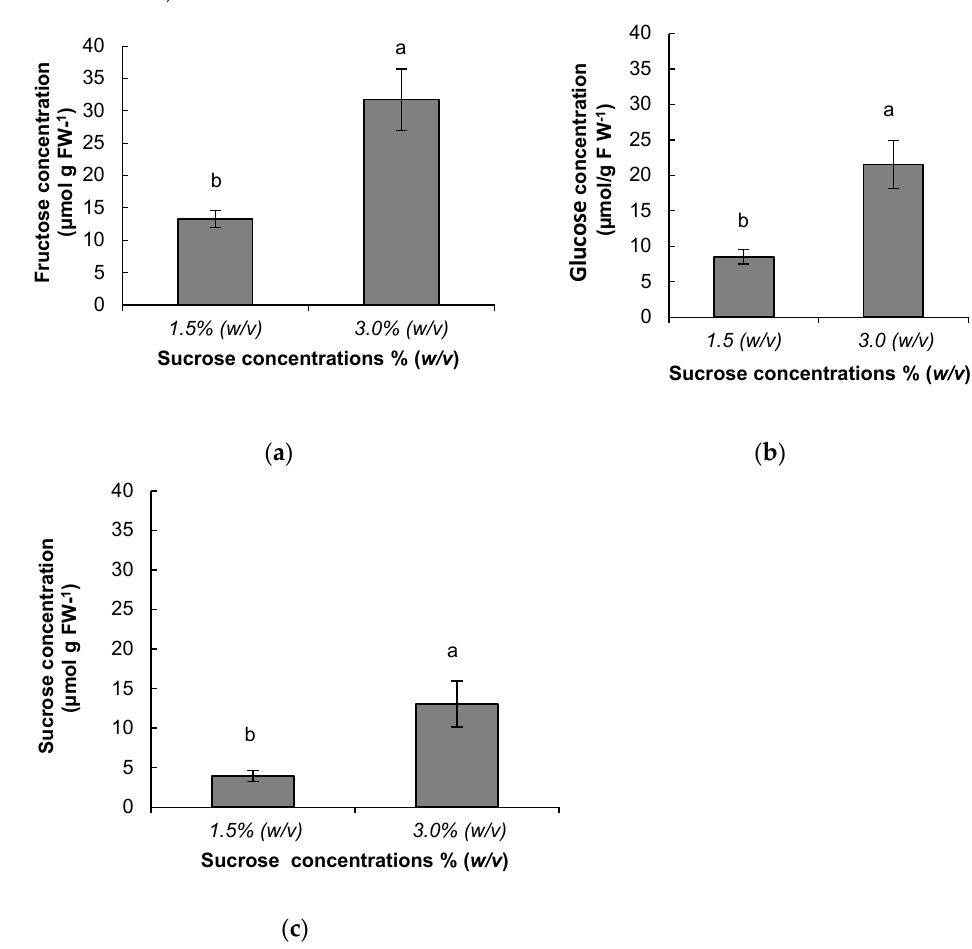
Figure 6. Effect of sucrose concentration (1.5% and 3.0% ( w / v )) on fructose ( a ), glucose ( b ) and sucrose ( c ) concentration of Pinus radiata D. Don shoots cultured in rooting medium (Quoirin and Lepoivre (LP) medium [27], modified according to Aitken-Christie et al. [28], supplemented with a mixture of 5 μ M 1 − Naphthaleneacetic acid (NAA) and 10 μ M indole − 3 − butyric acid (IBA)). Data are presented as mean values ± S.E. Different letters indicate significant differences by Duncan’s post hoc test ( p < 0.05).